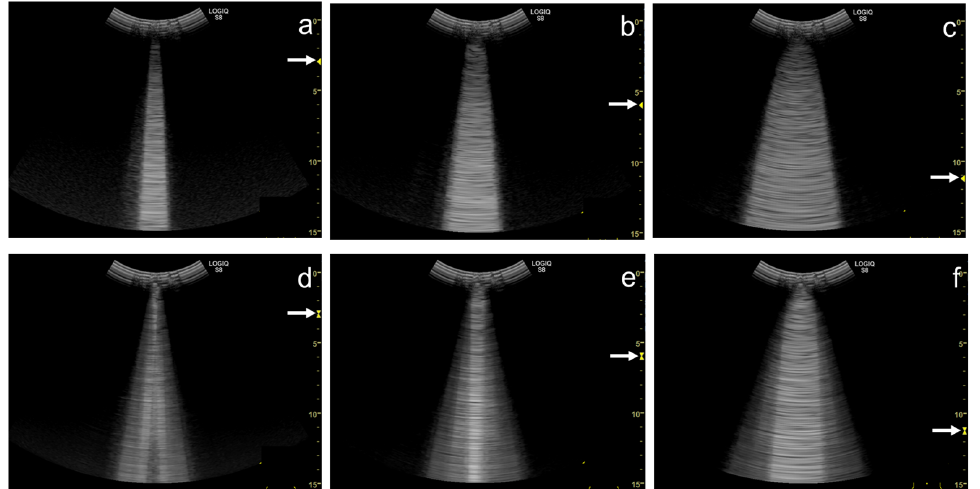
Figure 13. Ultrasound images obtained with the curvilinear transducer. The vertical artifact becomes wider as the focal point (arrow) is moved to deeper levels ( a – c ). When spatial compound imaging is enabled, three lines appear to overlap each other ( a , d ). The three lines become wider as the focal point (arrow) is moved to deeper levels ( d – f ).